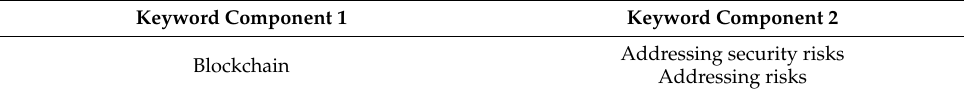
Table 3. Literature Review Keywords—Blockchain.